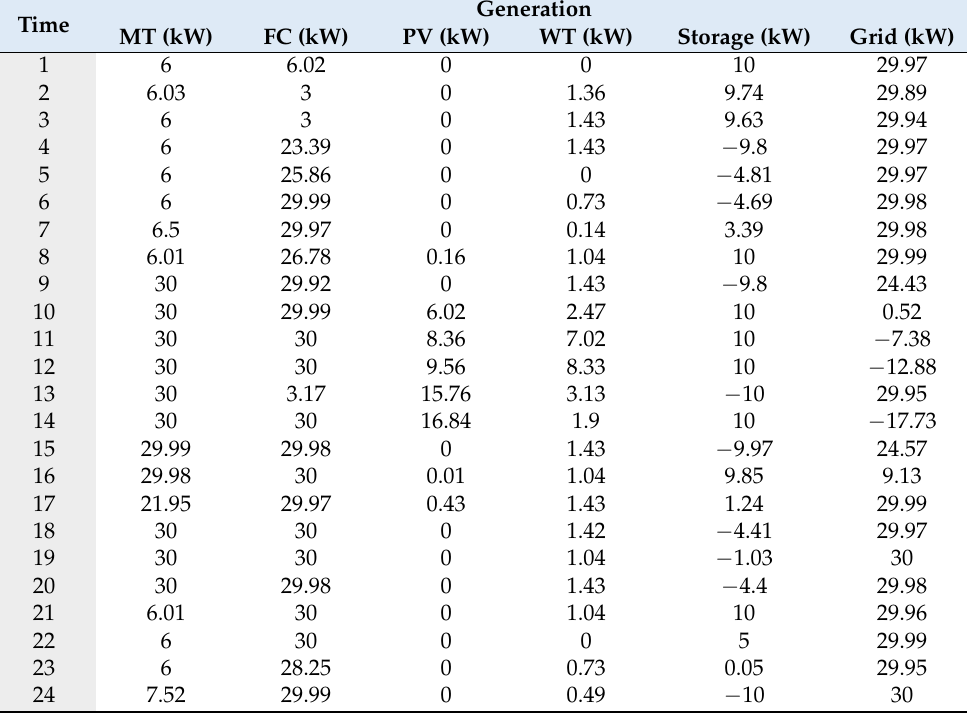
Figure 7. Comparing Pareto Fronts in different methods without considering the limits of upstream power exchange (cost and emission based). Table 14. Power distribution in a Pareto Front sample answer without considering the limits of upstream power exchange.